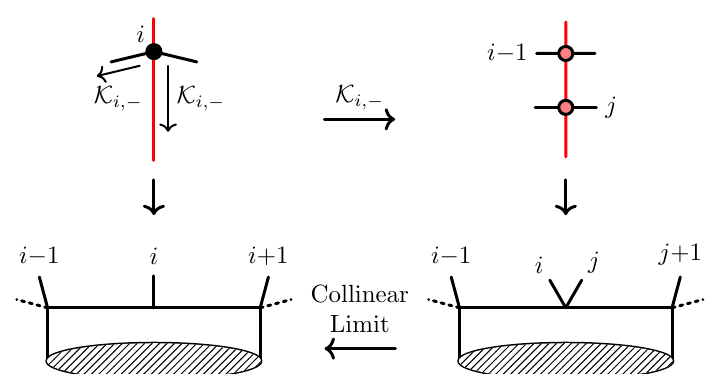
Figure 3. The graph operation K i maps an N k MHV twistor diagram into an N k+1 MHV twistor diagram as shown in the top row. On Landau diagrams, this corresponds to replacing a massless corner by a massive corner; such an operation is e(cid:11)ectively an inverse collinear limit. The shaded region in the (cid:12)gures represents an arbitrary planar sub-graph. A dashed external line on a Landau diagram may be either one massless external leg so the whole corner is massive, or completely removed so the whole corner is